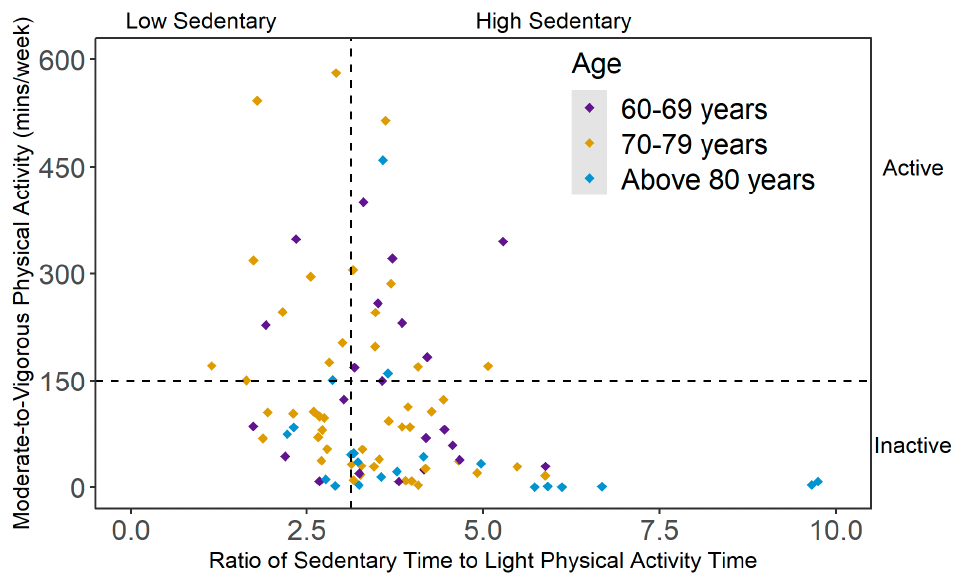
Figure 1. Scatterplot of mutually exclusive behavioral categories of physical activity (PA) and sedentary behavior (SB), stratified by age group. Note. Active = meeting 150 min/week of moderate- to-vigorous PA (MVPA); inactive = not meeting 150 min/week of MVPA; low sedentary = 1st tertile of the ratio between average sedentary time and average light PA (LPA) time; high sedentary = 2nd and 3rd tertiles of the ratio between average sedentary time and average LPA time. Table 1. Characteristics of study participants, expressed as means (SD).